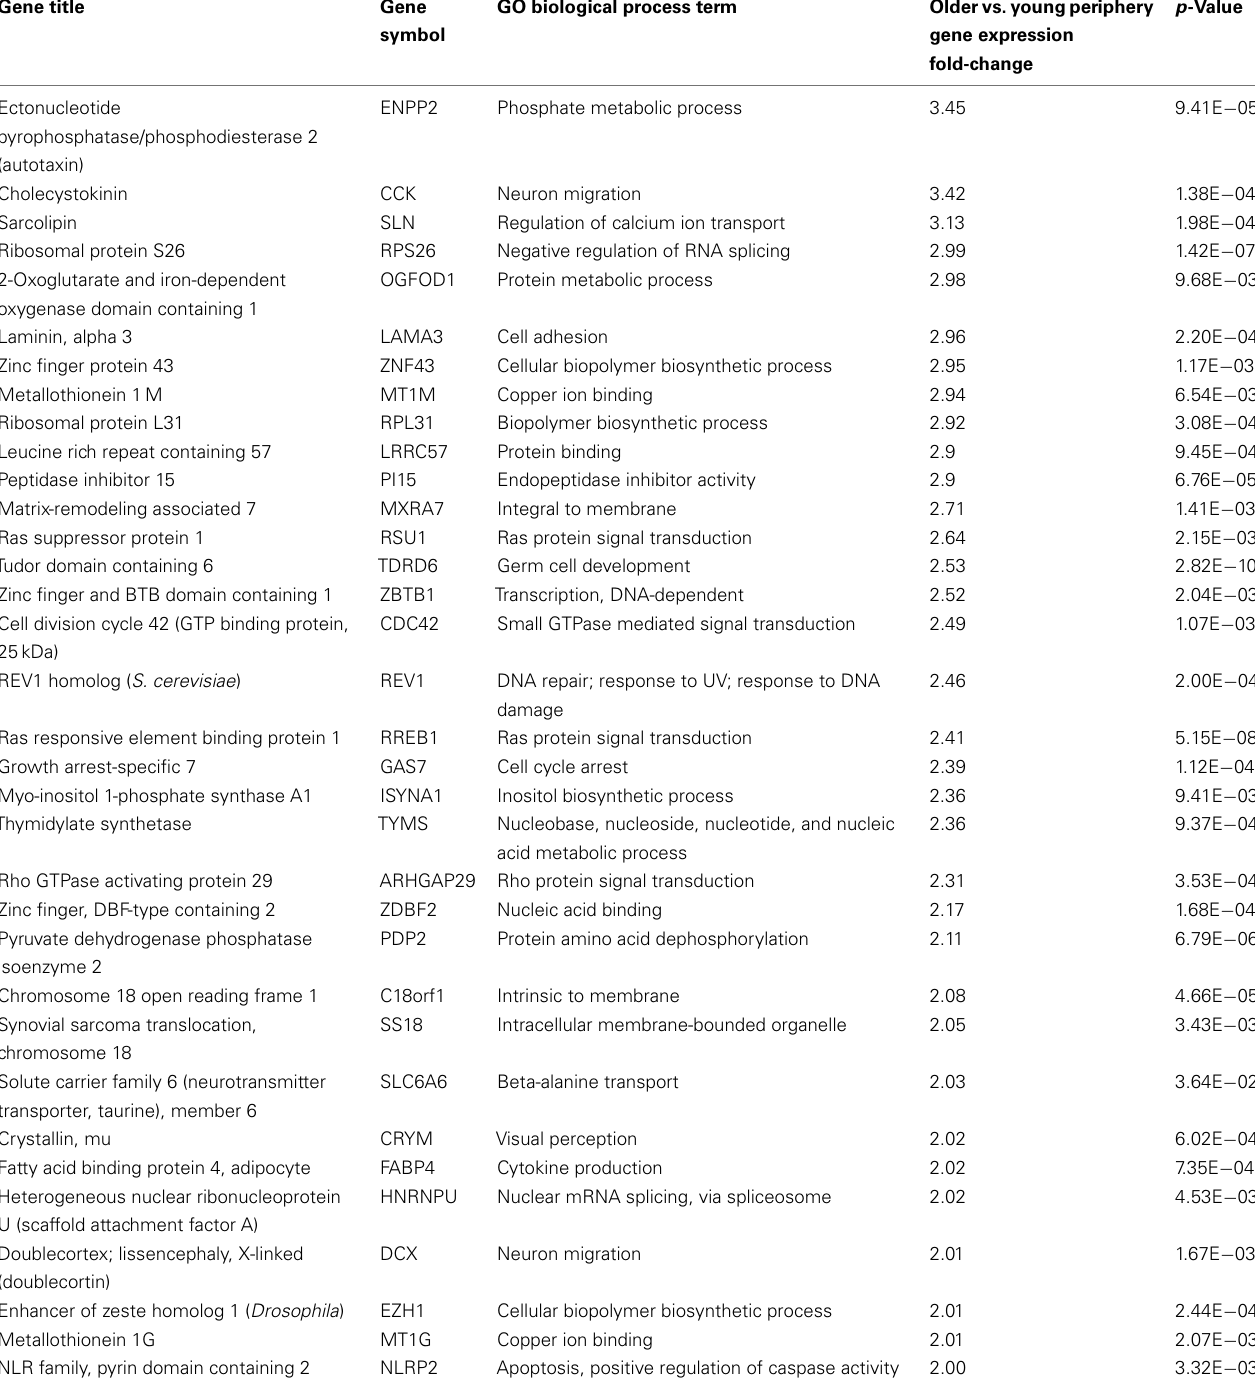
Table 8 | Genes highly expressed in old compared to young peripheral